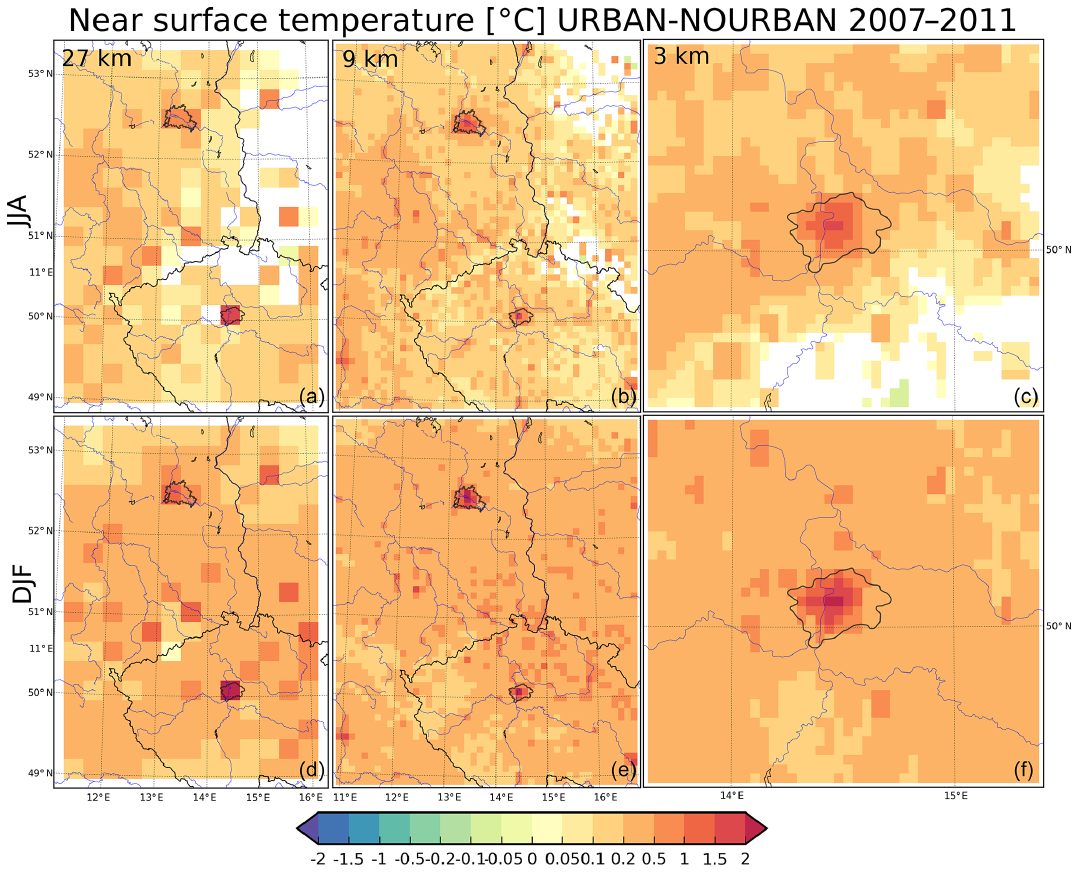
Figure 9. Impact of urban surfaces on near-surface temperature in ◦ C for JJA (a, b, c) and DJF (d, e, f) for the three resolutions (27, 9 and 3km). Shaded areas represent statistically significant changes over the 98% threshold using a two-tailed t test. The geographic locations of Berlin and Prague are indicated by their administrative